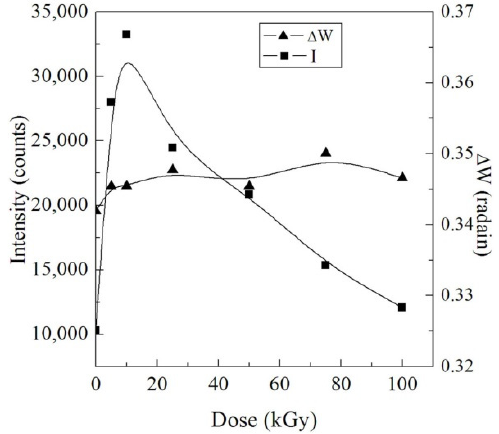
Figure 2. Variation of I and Δ W with the γ dose.